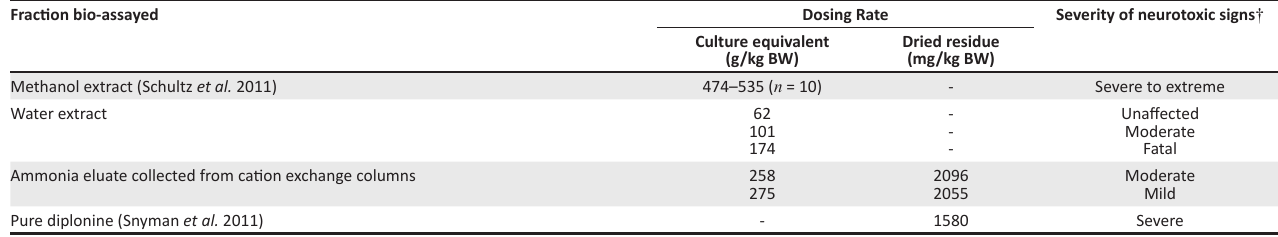
Methanol extract (Schultz et al. 2011)